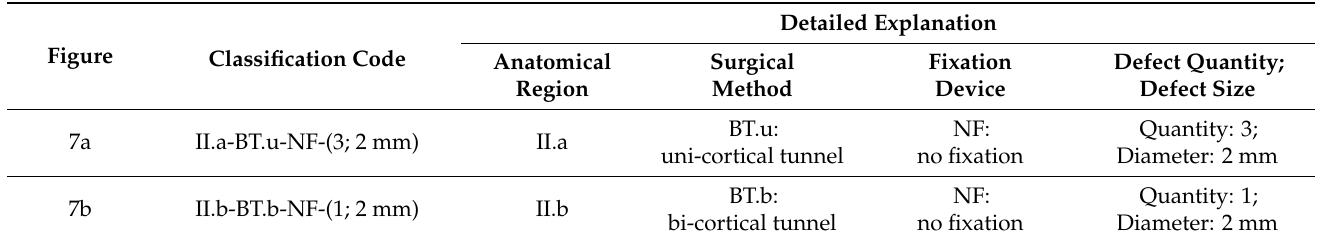
Table 1. Detailed explanation of the classification coding for virtual surgeries in Figure 7.